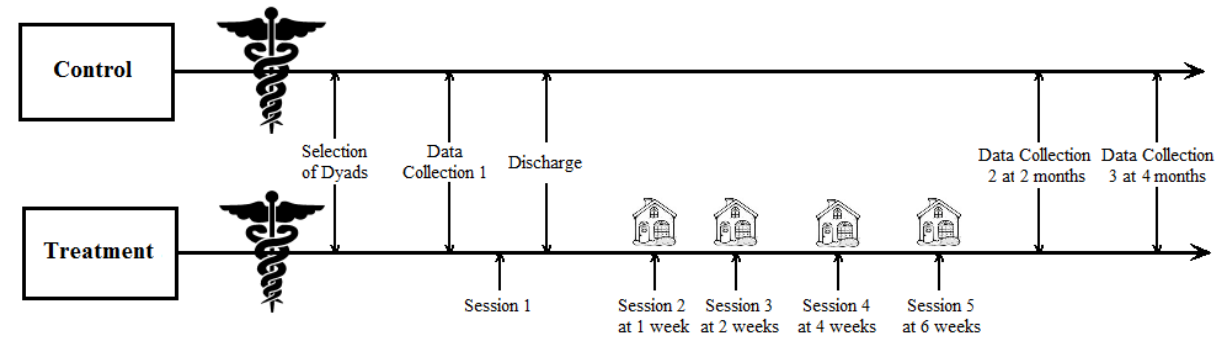
Figure 1. Randomized controlled trial